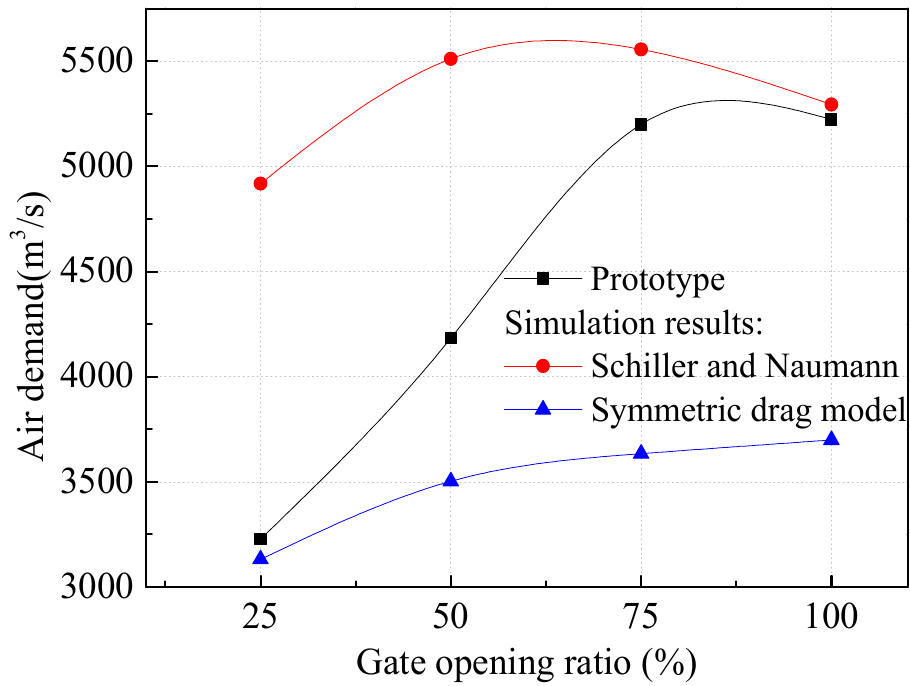
Figure 4. Air demand comparison between prototype observation and numerical simulation. In order to reveal the difference between the drag models, several typical sections were selected. Water velocity, air velocity, and air volume fraction α a on the center line of these sections were extracted. As the water velocity from different drag models showed little discrepancy, only one profile for water velocity was plotted on every subfigure. In Figure 5, the profiles of air velocity in the location where α a < 1 was close to the water velocity. This indicates that in the calculation of this paper, whether the Schiller and Naumann model or the Symmetric model was adopted, the distribution of air velocity in the water body would eventually be consistent with the profile of water velocity. However, near the air–water interface where α a transforms from α a < 1 to α a = 1, the difference of the air velocity profile calculated from two models appeared. The air velocity calculated by the Symmetric model was obviously distorted here, and the large gradient resulted in a suddenly decrease of air velocity. The results of the symmetric drag model are generally smaller than those of the Schiller and Naumann models. Nevertheless, it is necessary to provide a more proper drag model since it has a great influence on the calculation of air demand of a spillway